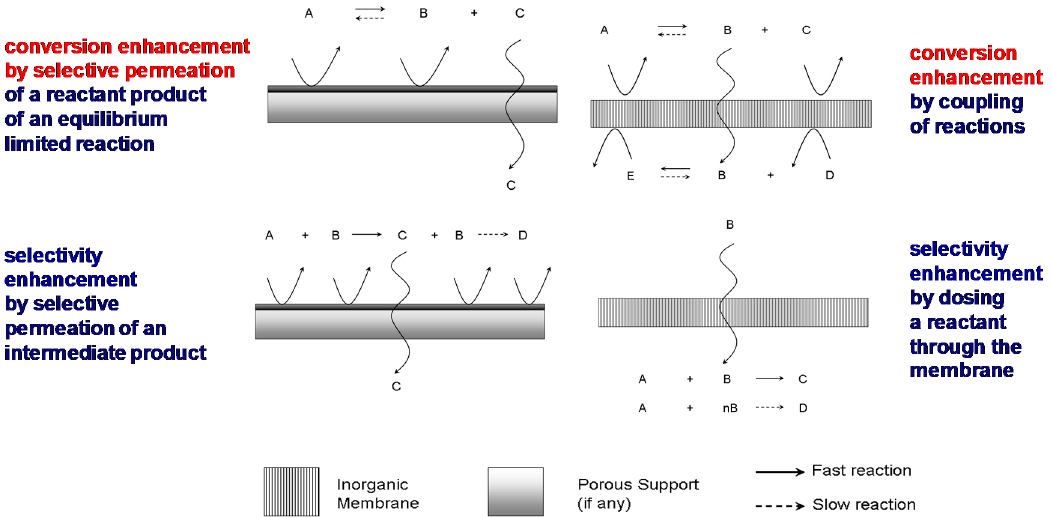
Figure 4. Main application possibilities of (inorganic) membrane reactors.